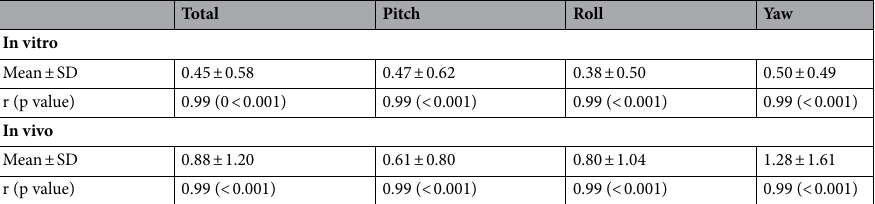
Table 1. Summary table comparing the inertial measurement unit to the cervical range of motion device. The mean and standard deviation (SD) of the differences represents the average of the absolute difference between the cervical range of motion device (gold standard) and the inertial measurement unit. The Pearson correlation (r) with the respective p value is also shown.